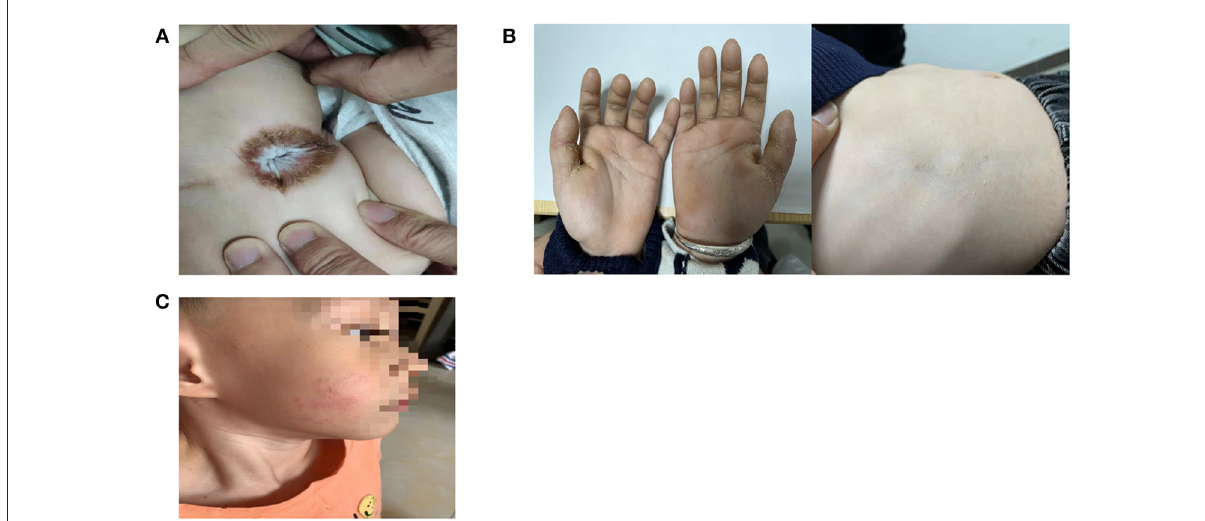
FIGURE2 (A) The result of Sanger sequencing analysis. (B) Pedigree and variants identified in KDSR.